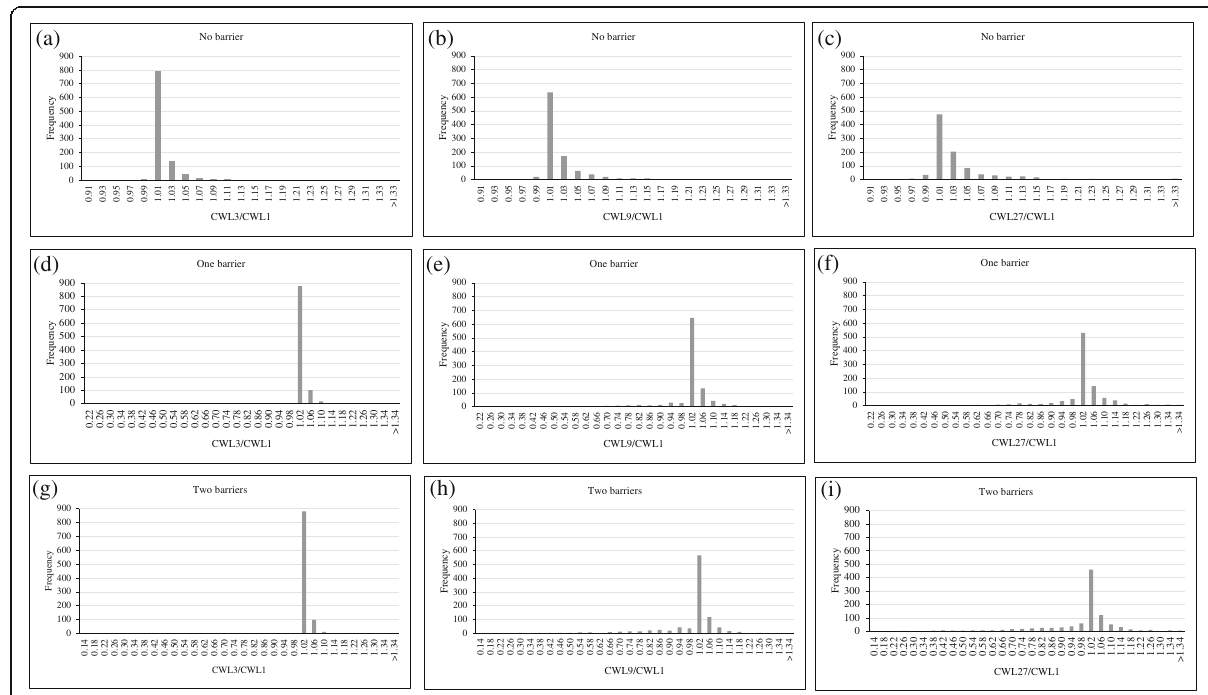
Fig. 5 Frequency distributions of 1000 sample values of CWL3/CWL1, CWL9/CWL1, and CWL27/CWL1 on cost surfaces with a – c no barriers, d – f one barrier, and g – i two